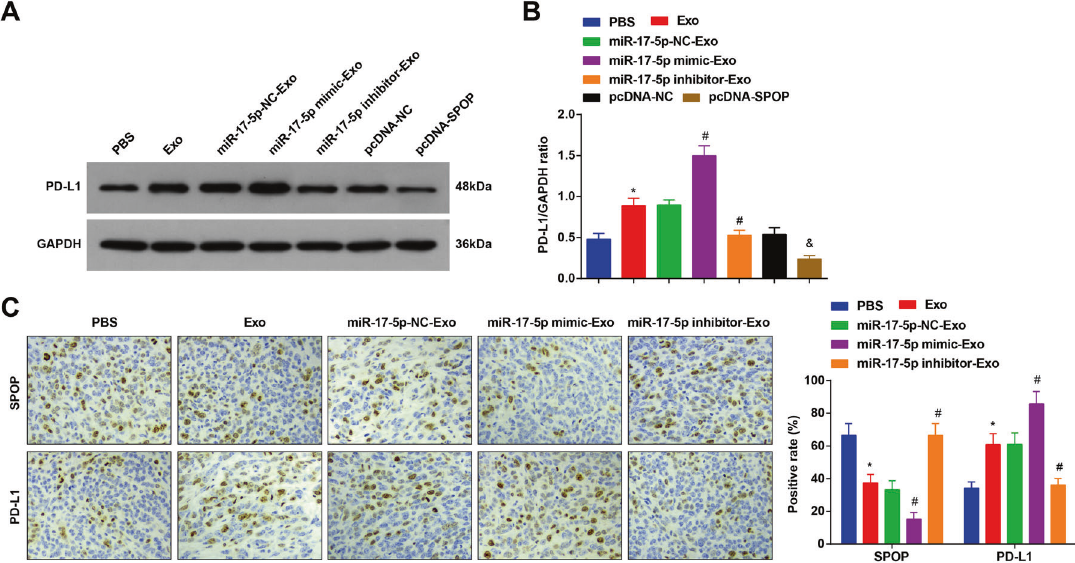
Fig. 8 MiR-17-5p targets SPOP to upregulate PD-L1, thus affecting the anti-tumor immunity in CRC cells. A , B PD-L1 expression in HCT116 expression detected using western blot analysis after treatment with miR-17-5p-mimic/inhibitor- Exo; C SPOP and PD-L1 levels examined using immunohistochemistry after treatment with miR-17-5p-mimic/inhibitor -Exo ( n = 5); cell experiments were repeated three times and there were 5 mice in each group; * P < 0.05 vs the PBS group, # P < 0.05 vs the miR-17-5p-NC-Exo group, & P < 0.05 vs the pcDNA-NC group; the measurement data were expressed as mean ± standard